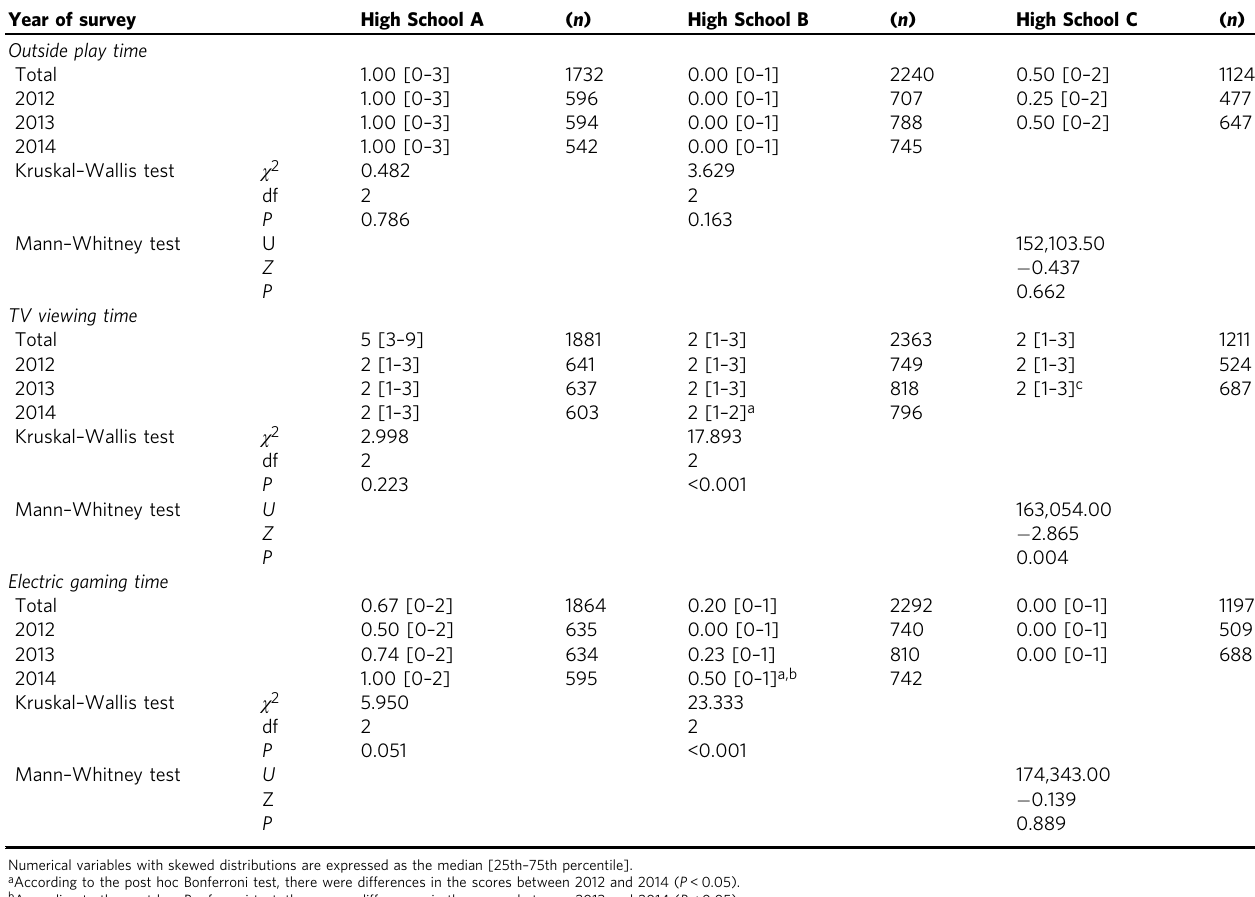
Table 2 Longitudinal changes in physical behaviours: outside play time, TV viewing time, and electronic gaming time. Year of